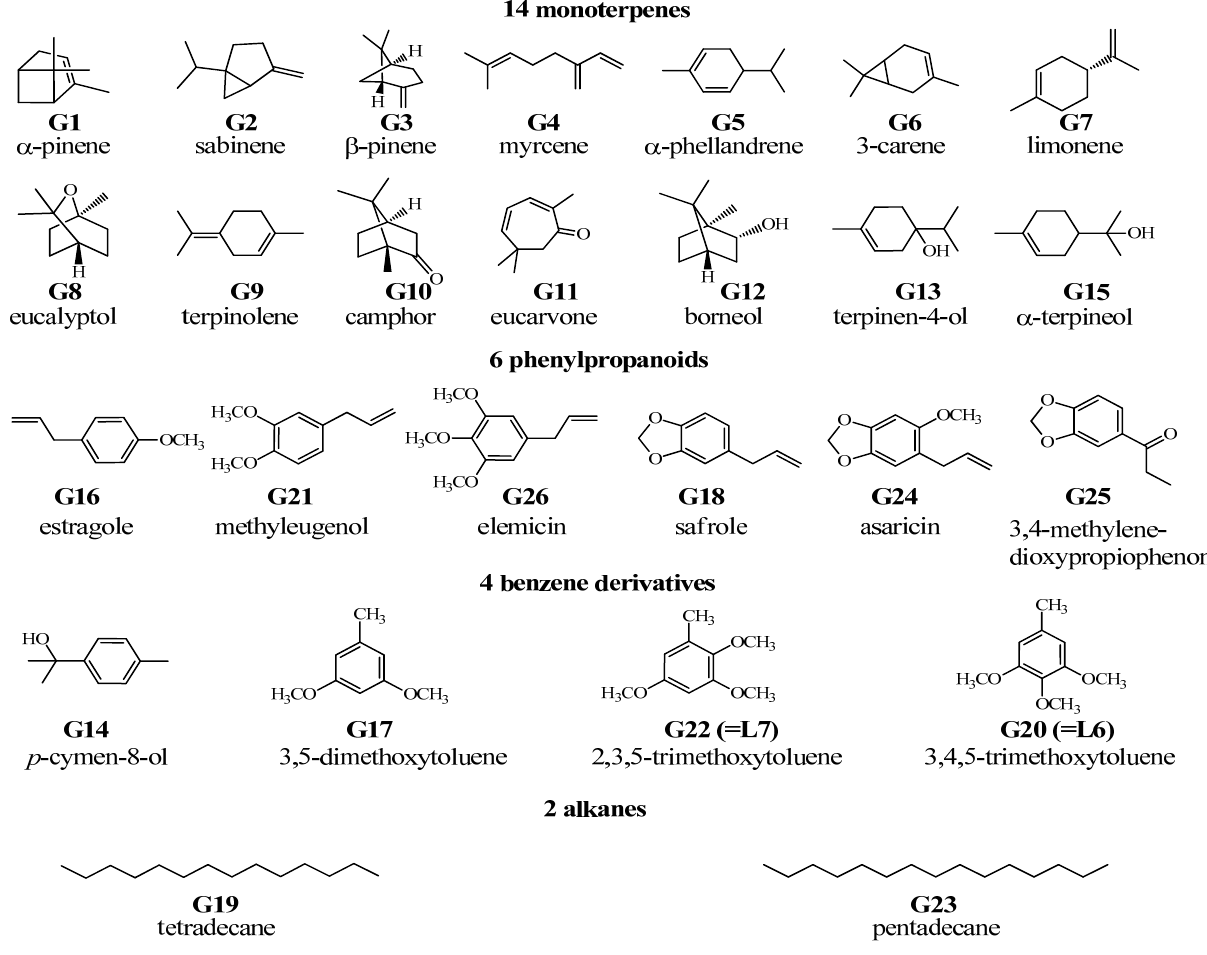
Figure 5. Chemical structures of 26 absorbed constituents identified in rabbit plasma and CSF from AR EtOAc extract group and the AR powder group identified by